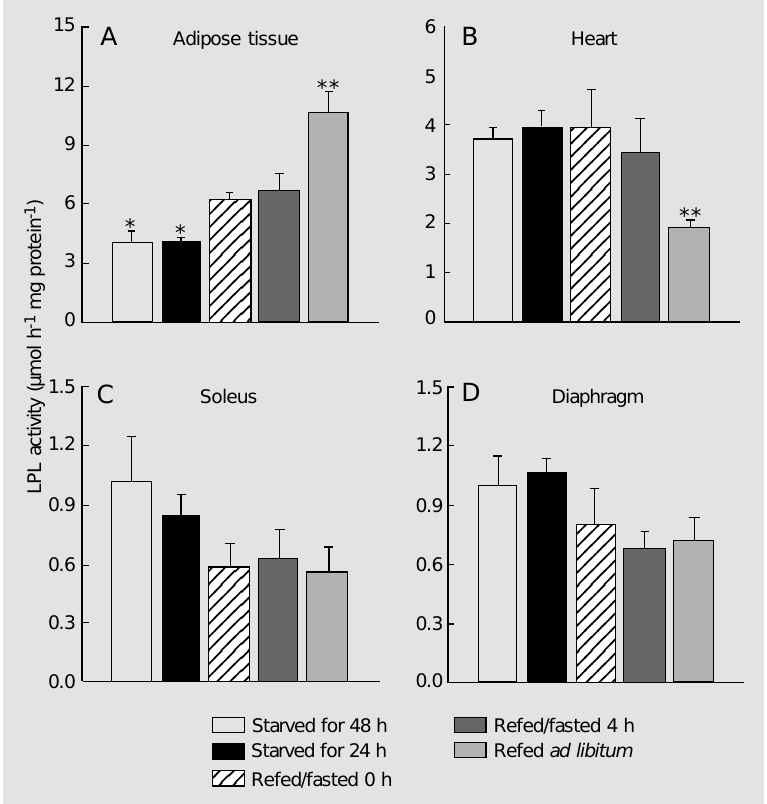
Figure 1. Lipoprotein lipase (LPL) activities in epididymal adipose tissue (A) and in heart (B), soleus (C) and diaphragm (D) muscles during progressive starvation and refeeding after 24- h starvation. Tissue LPL activities (mean ± SEM) were measured in homogenates obtained from Wistar rats starved for 48 h (N = 6), starved for 24 h (N = 10), refed/fasted 0 h (N = 6), refed/fasted 4 h (N = 6), and refed ad libitum (N = 10). *P<0.05 for starved vs refed groups; **P<0.05 vs other groups (unpaired Student t